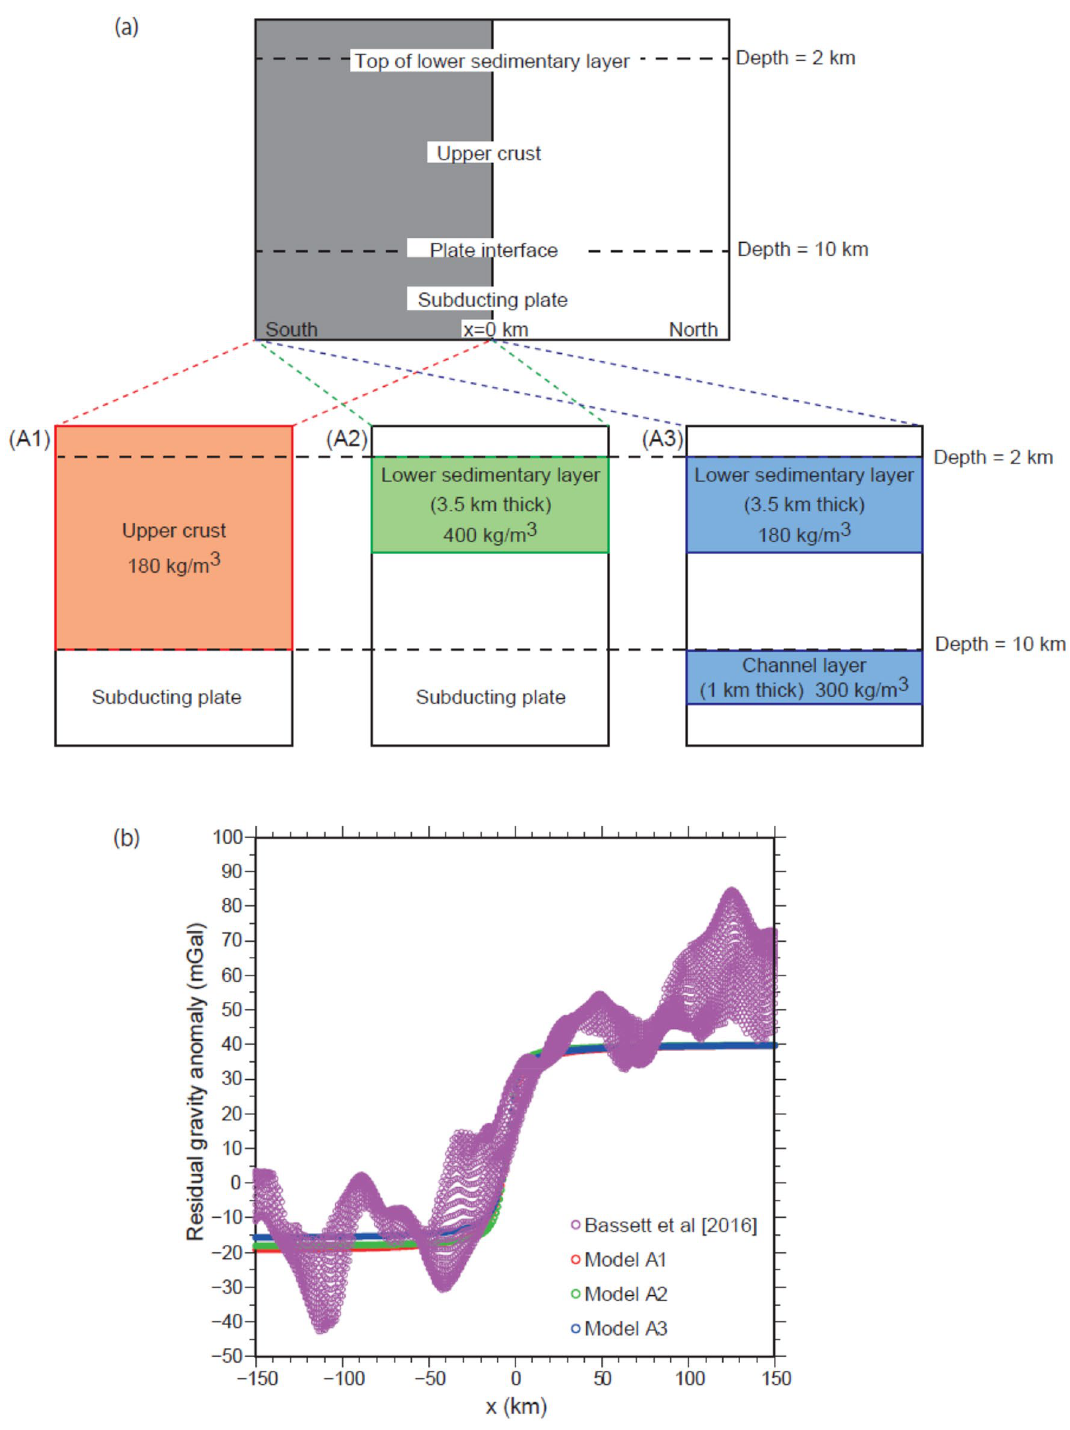
Figure 2. ( a ) Schematic of the density distribution model. Models A1–A3 represent the southern segment of the Japan Trench (grey area in the upper panel). ( b ) Residual gravity anomaly estimated from various density distribution models. Purple lines indicate the residual gravity anomaly (from Bassett et al. 15 ). Red, green, and blue lines indicate results obtained using Models A1, A2, and A3,